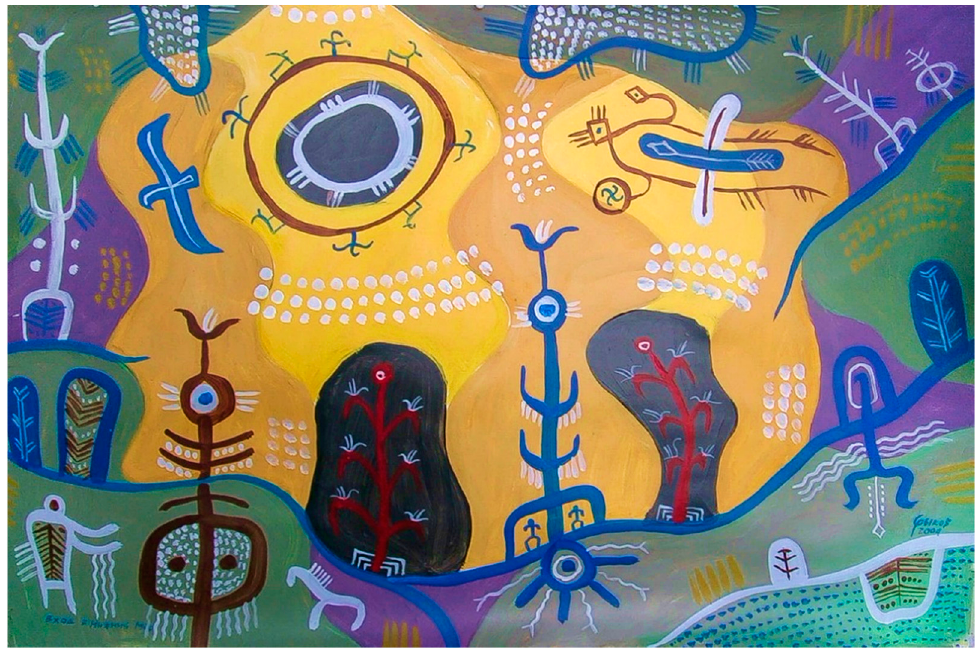
Figure 5. Sergei Dykov, Entrance to the Lower World , 2004, acrylics on paper. Courtesy S. Dykov.